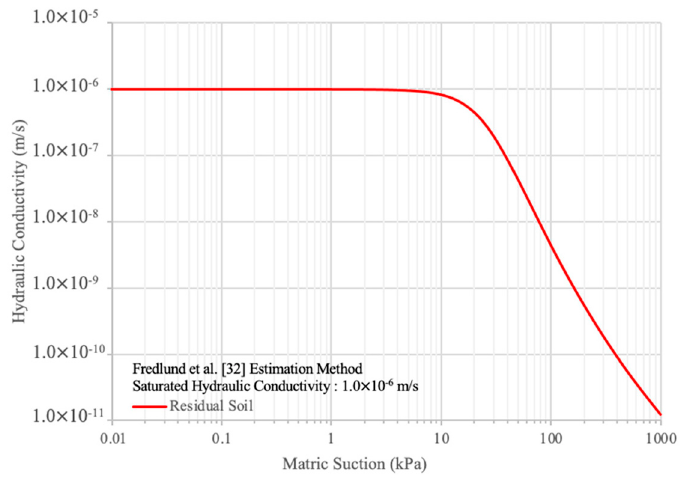
Figure 4. Unsaturated permeability function for BTG residual